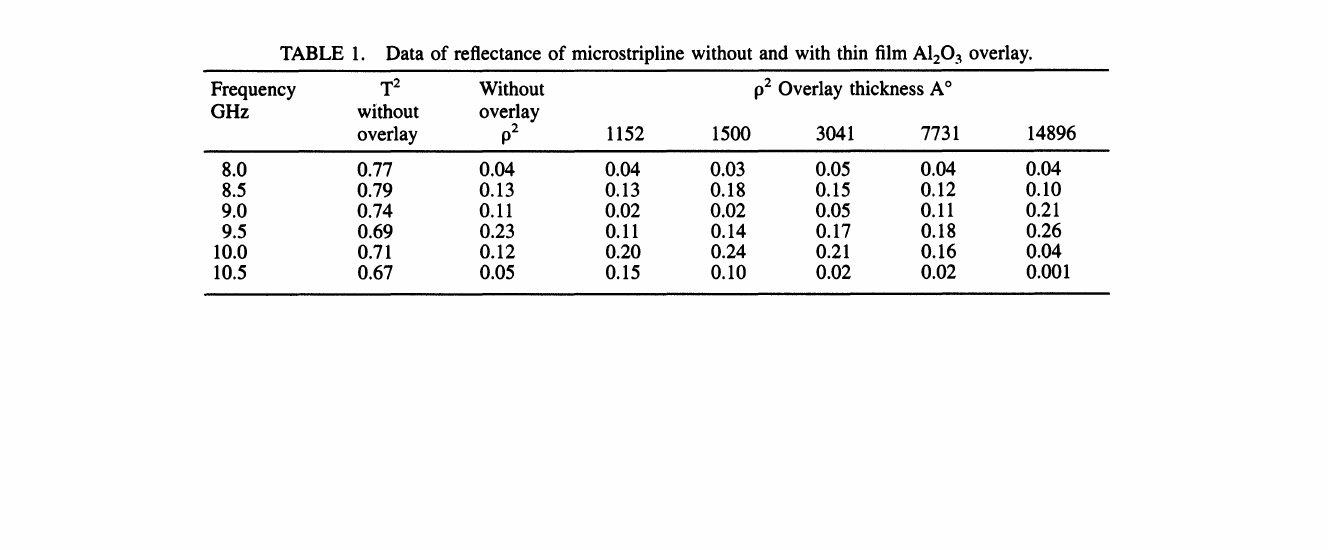
TABLE 1. Data of reflectance of microstripline without and with thin film A1203 overlay. Frequency T Without p2 Overlay thickness A GHz without overlay